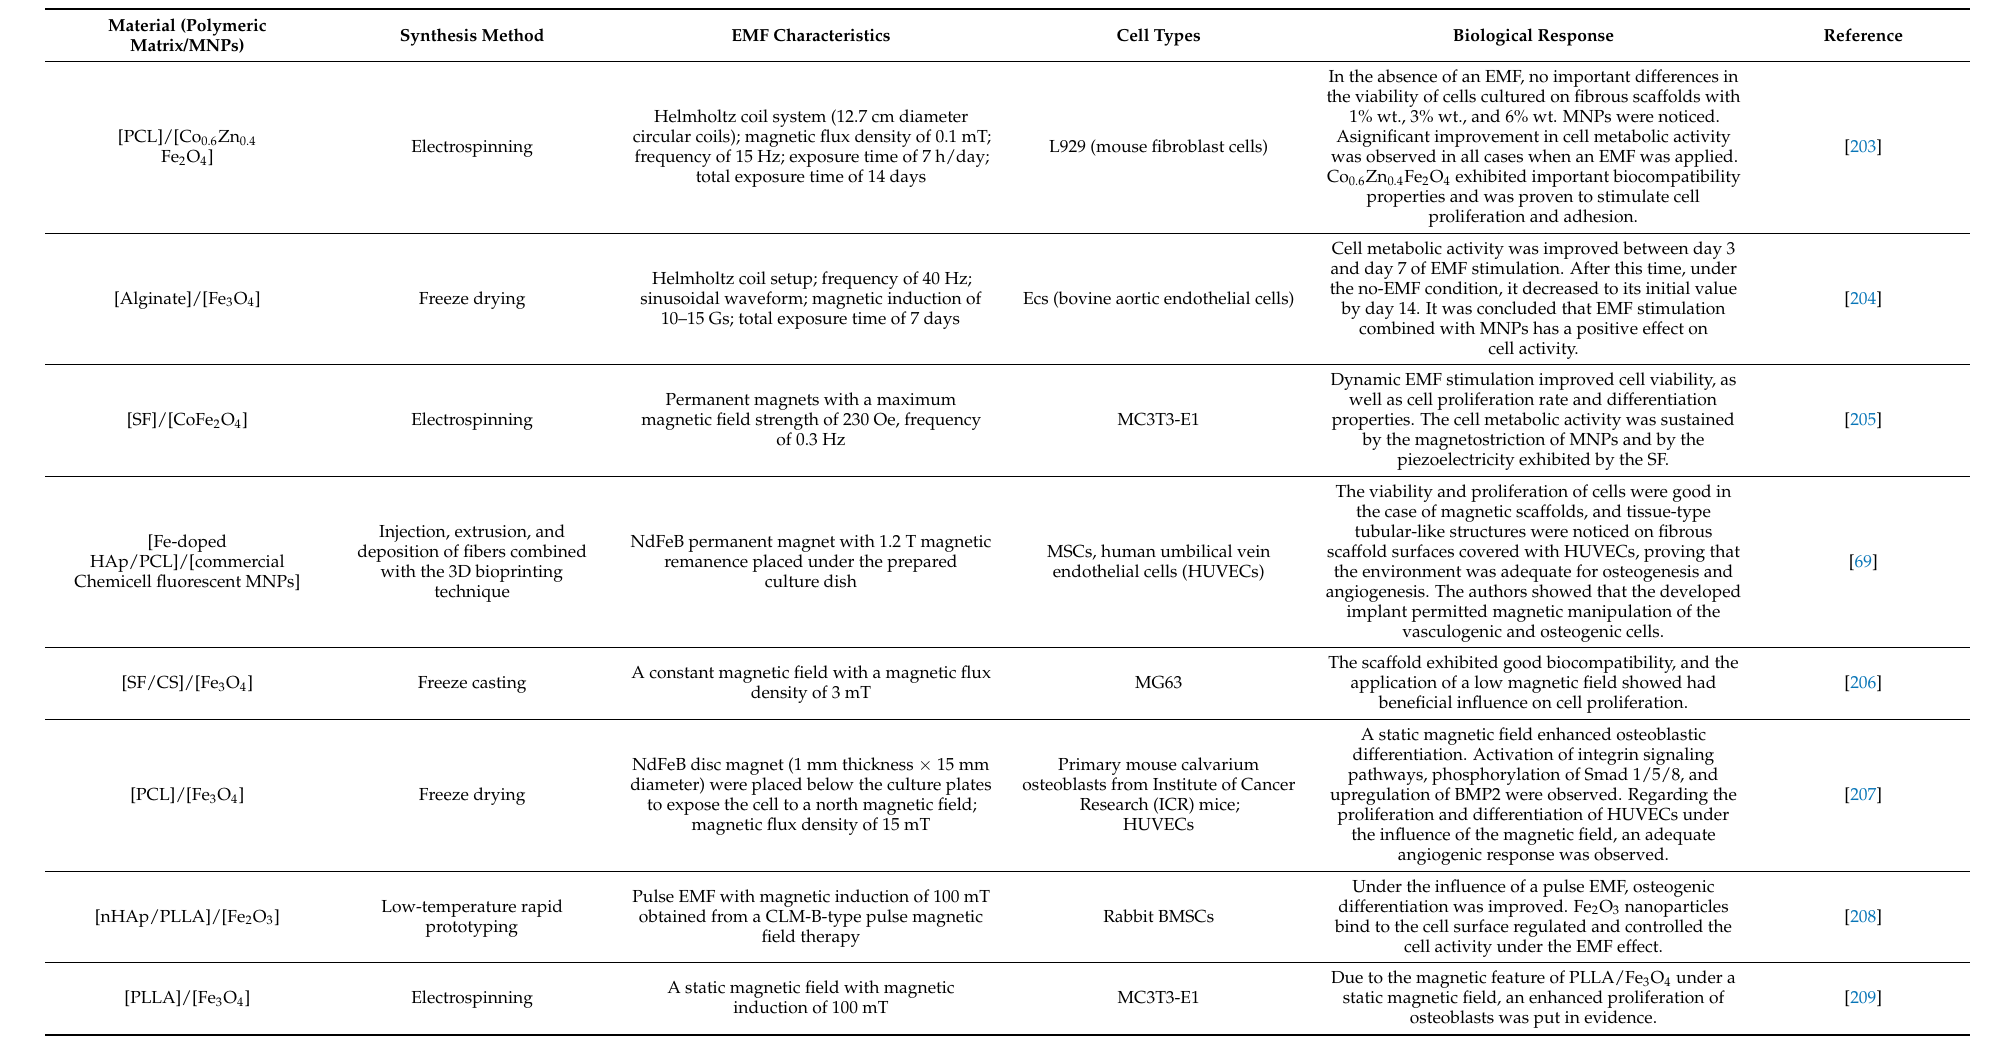
Table 6. Magnetic polymeric scaffolds under EMF exposure in